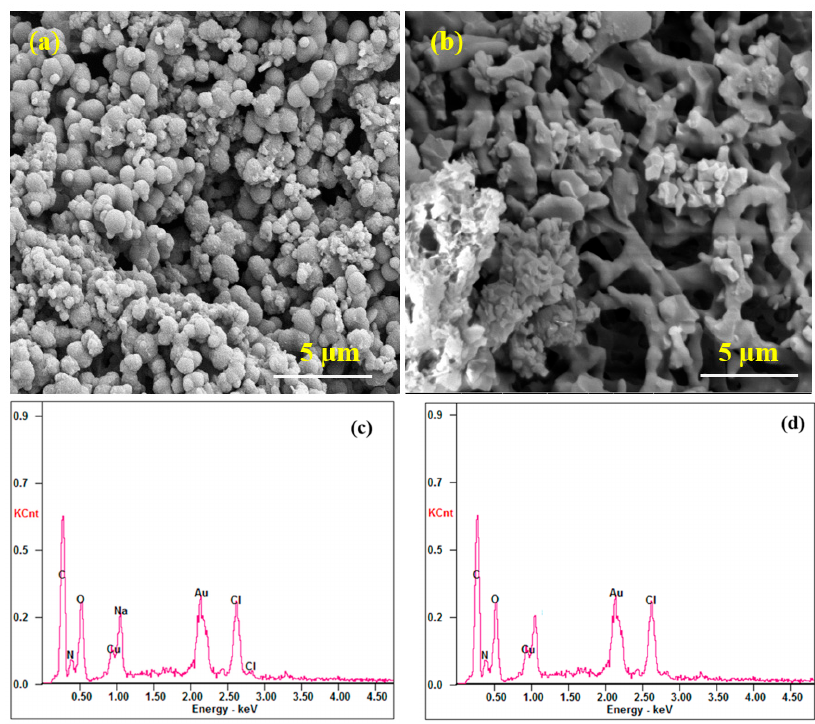
Figure 2. SEM and EDX images of the polymer composites. Notes: ( a , b ) SEM of polypyrrole (PPY)-Zn@CuO, polyaniline (PANI)-Zn@CuO; ( c , d ) EDX of PPY-Zn@CuO, PANI-Zn@CuO.